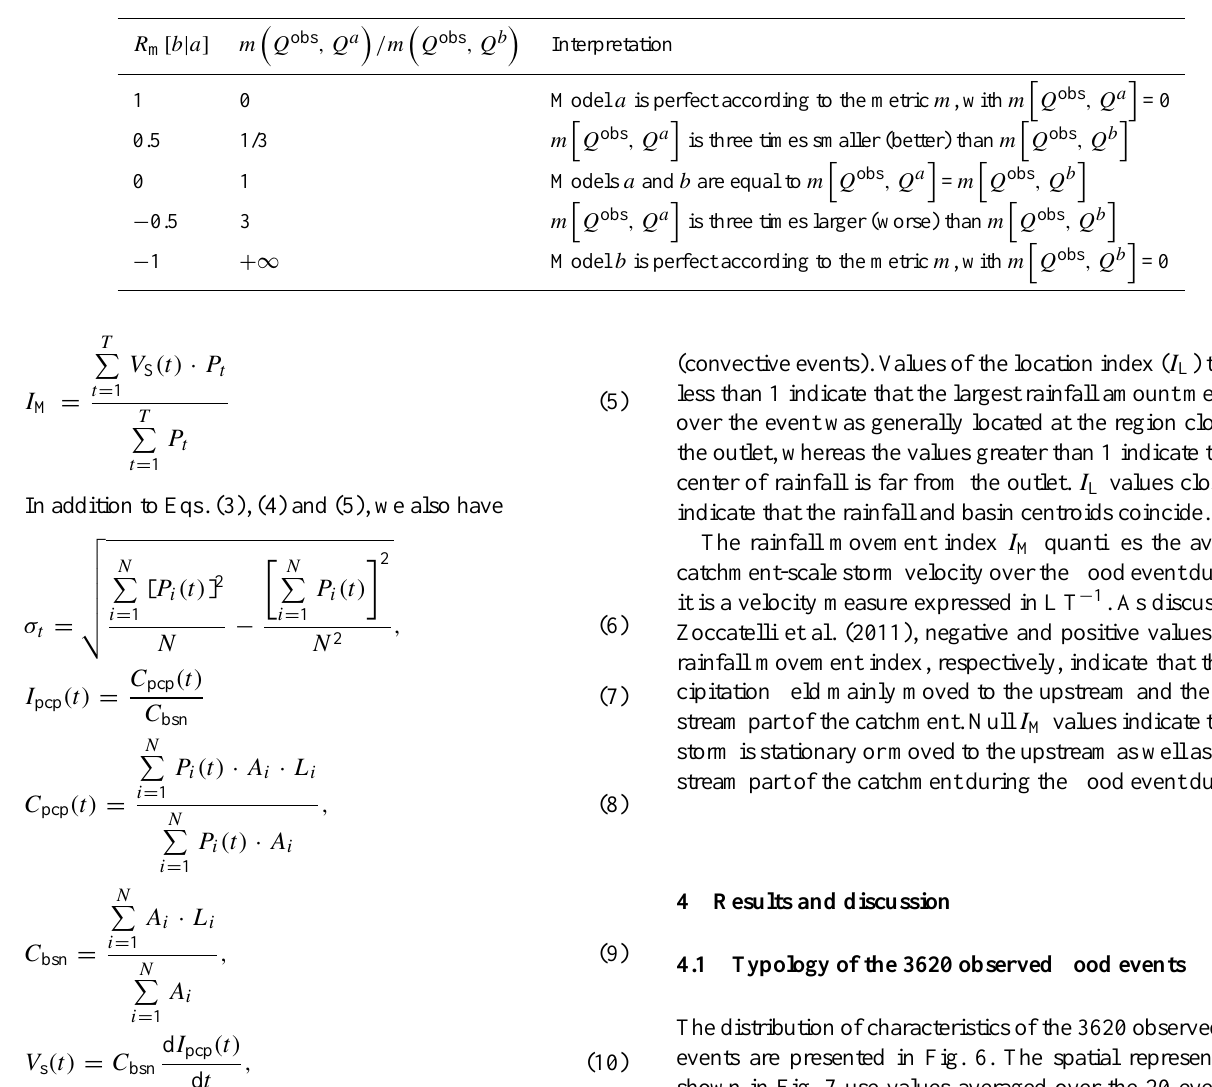
Table 4. Interpretation of the relative performance index R m [ b | a ] comparing the performance of model b to the reference model a using a metric m (Lerat et al.,